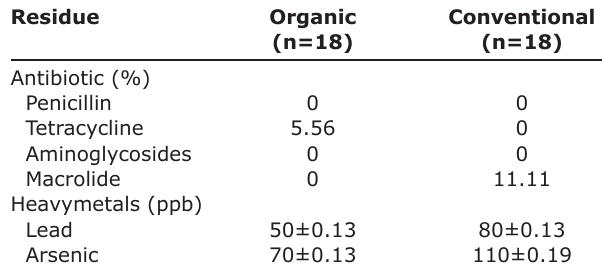
Table-4: Antibiotic and heavy metal residues in organic and conventional goat milk.